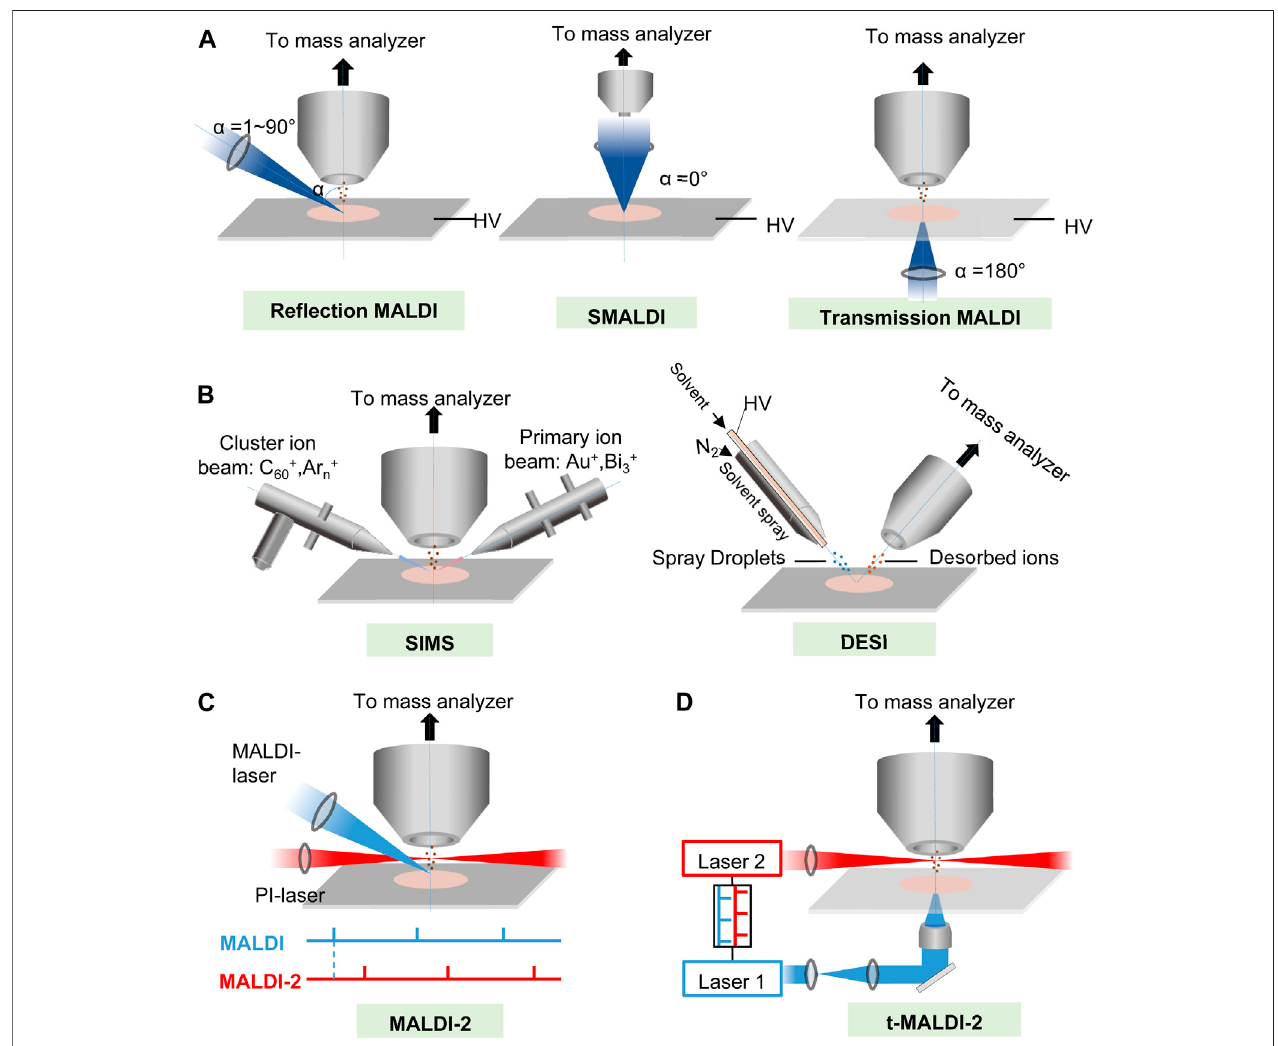
FIGURE 1 | The principles of (A,B) major MSI ionization methods and (C,D) two kinds of new post ionization (PI) laser enhanced new high-resolution MALDI ion sources. (A) Schematic of MALDI at several different laser angles ( α ). HV, high voltage. (B) Schematic of SIMS and DESI. (C) Schematic drawing of the modi fi ed MALDI ionsourceoftheSynaptG2-Smassspectrometer.PrimaryMALDIandPIlaserbeamsformorecompleteionizationandshieldingapertureforincreasingthecoolinggas pressure in the region of ion generation. The lower panel illustrates the laser pulse triggering sequence. (D) Schematics of t-MALDI-2 – MSI. An actively Q-switched Nd: YLF laser (laser 1, λ (cid:1) 349 nm, M2 ∼ 1.05) is focused onto a matrix-coated sample via a UV-transmitting × 50 objective in back-side illumination geometry. The Nd: YAG laser (laser 2 wavelength 2,266 nm) intersects the extended analyte matrix plume at a certain distance and a certain delay between the two laser pulses.